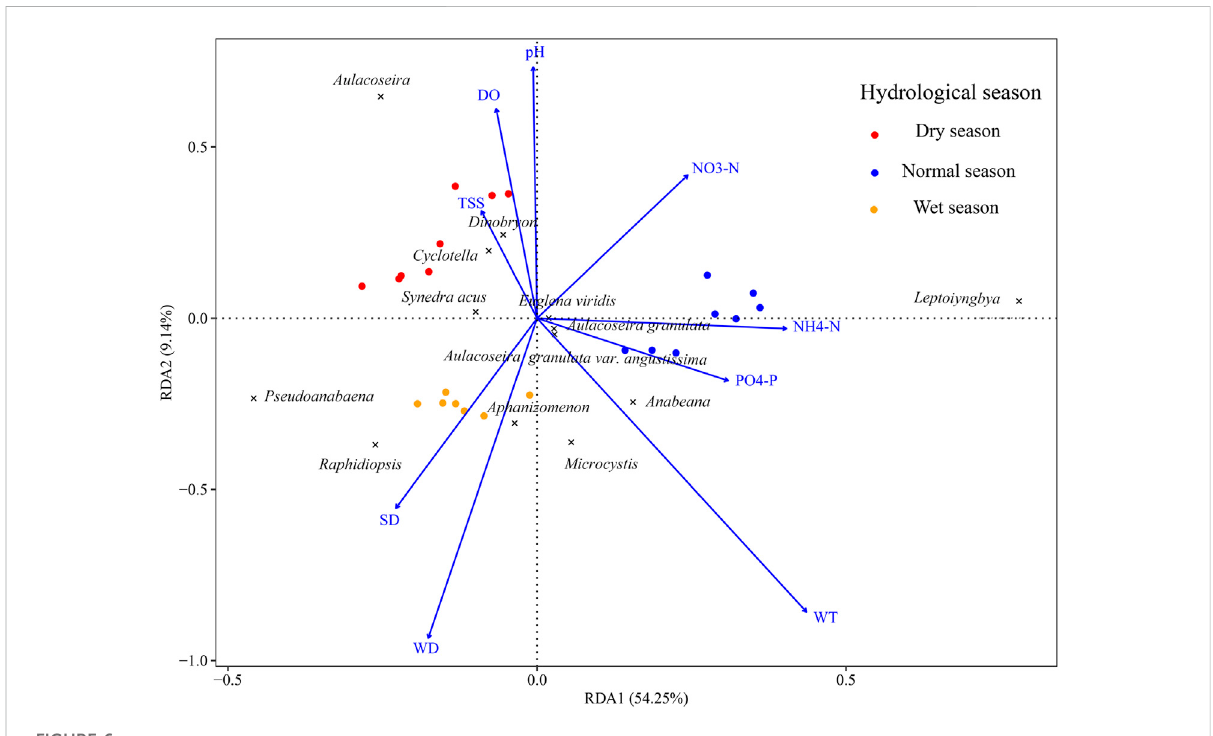
FIGURE 6 RDA plot of the dominant phytoplankton species and environmental